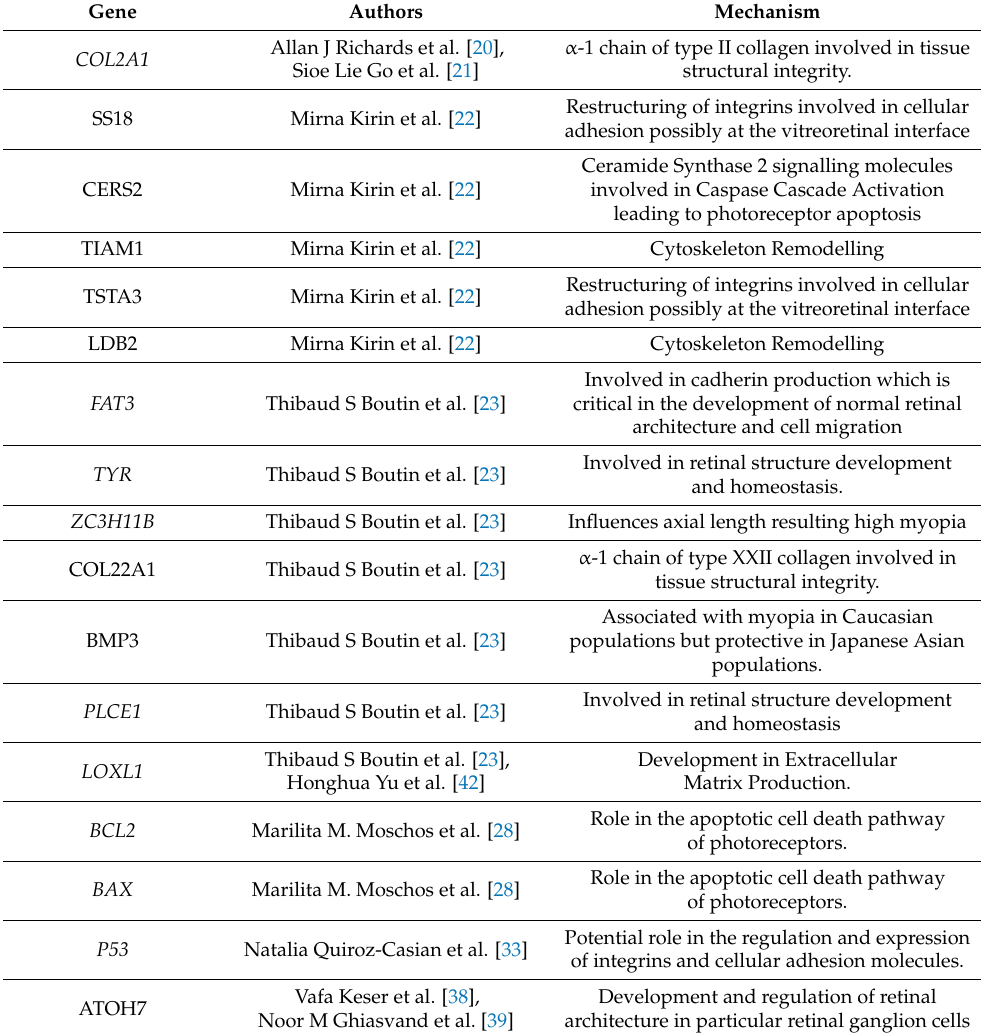
Table 1. Summarises some of the significant genes associated with IRD described